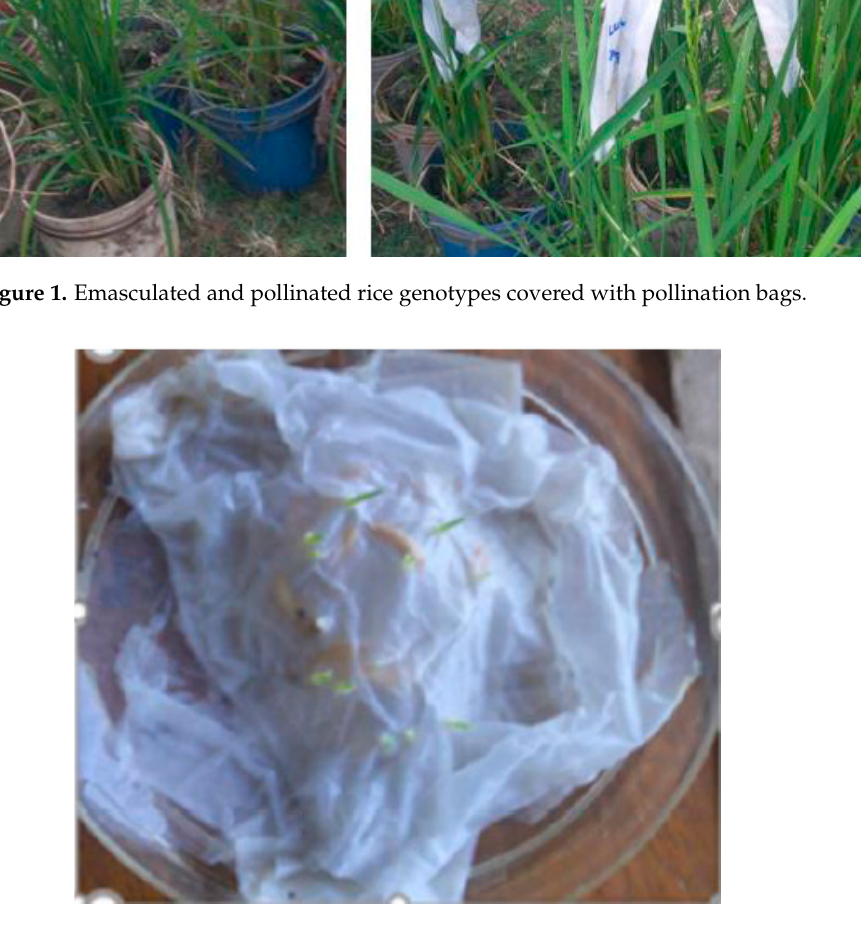
Figure 2. Germinating F1 seed in a Petri-dish being advanced to F2.